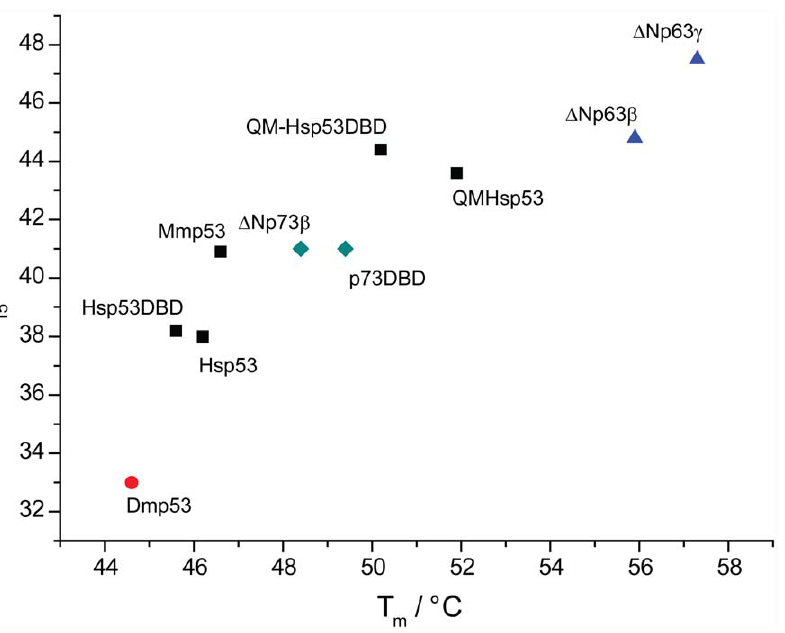
Figure 6. Correlation between kinetic ( T 15 , unfolding of DBD) and thermodynamic ( T m , DSF) stability data. Mammalian p53 proteins studied are represented by black squares, human p63 isoforms by blue triangles, human p73 constructs by green diamonds and Dmp53 by a red circle.